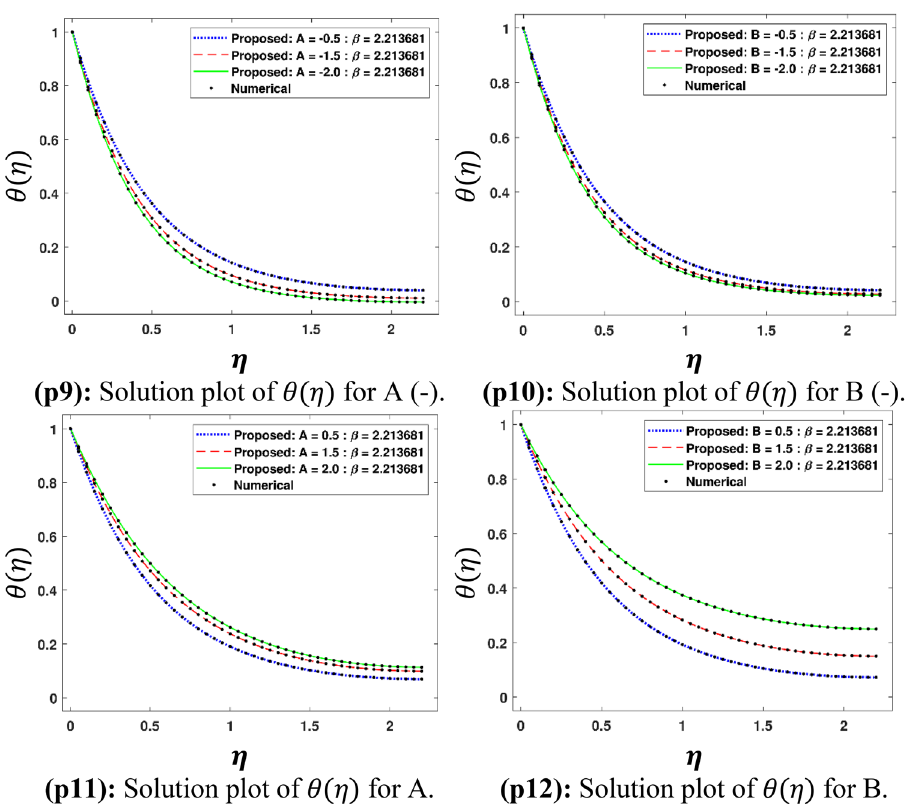
Figure 14. Solution plots of θ(η) by using the proposed